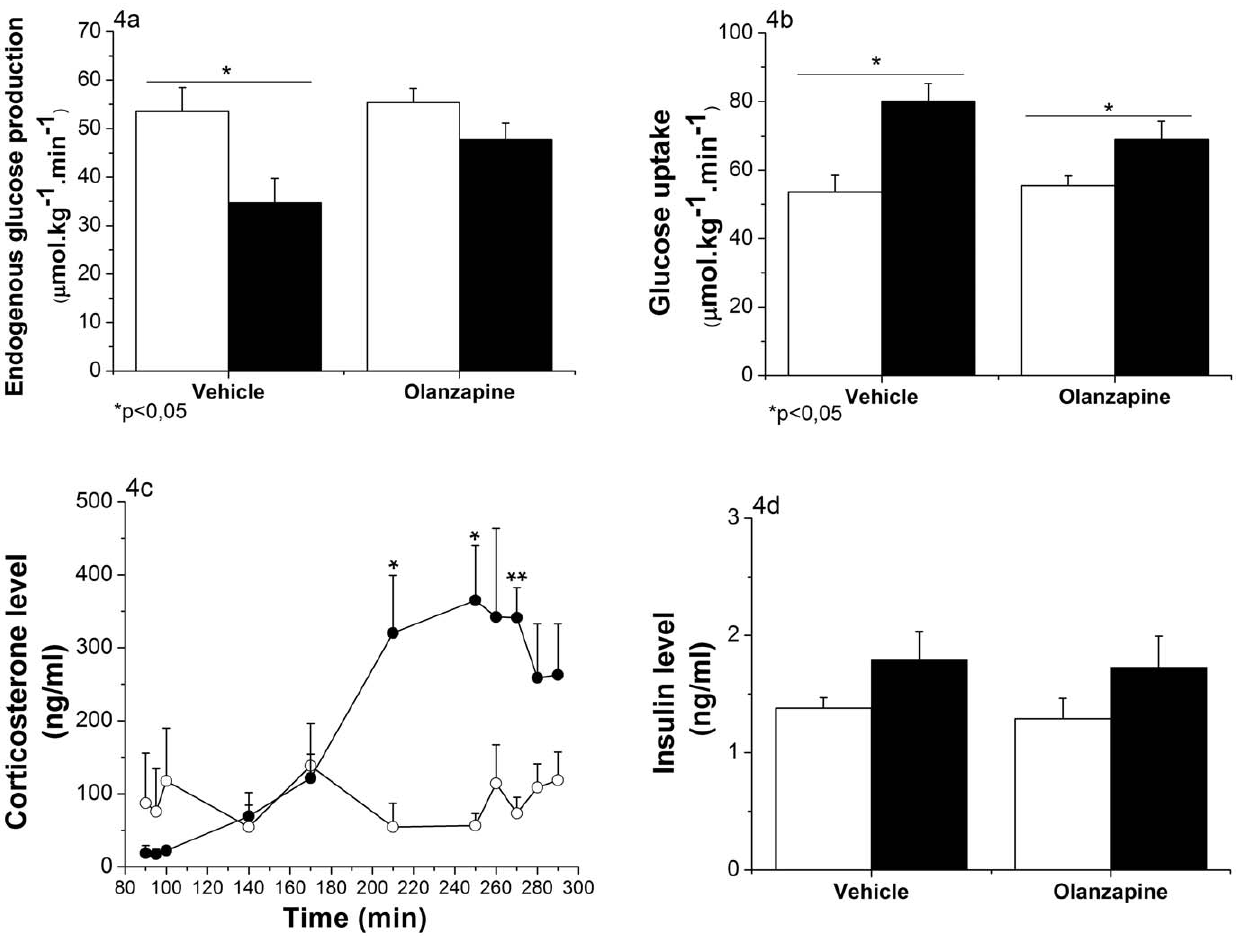
Figure 4. Effects of intragastric infusion of Olanzapine on liver insulin sensitivity (Experiment 2). (Vehicle group n=8, Olanzapine group n=7) 4a: Endogenous glucose production at basal (mean of 3 time points: t=90 to t=100; white bars) and during the hyperinsulinemic state (mean of 5 time points: t=250 to t=290; black bars). EGP significantly decreased during the hyperinsulinemic state for the vehicle group (p=0.018, One- Way ANOVA) and remained unchanged in the Olanzapine group (p=0.111, One-Way ANOVA). 4b: Glucose uptake at basal (mean of 3 time points: t=90 to t=100; white bars) and during the hyperinsulinemic state (mean of 5 time points: t=250 to t=290; black bars). Glucose uptake is significantly increased in both the vehicle (p=0.002, One-Way ANOVA) and Olanzapine group (p=0.046, One-Way ANOVA). 4c: Plasma corticosterone levels were significantly elevated by the IG infusion of Olanzapine (ANOVA repeated measures; Time, p , 0.001; Time * Group, p , 0.001; Group, p=0.039). Vehicle-treated animals = white dots; Olanzapine-treated animals = black dots. 4d: Plasma insulin levels were elevated 1.3-fold during the hyperinsulinemic state (mean of 3 time points; black bars) compared to the basal level (mean of 2 time points; white bars) (ANOVA repeated measures; Time, p=0.062; Time * Group, p=0.956; Group, p=0.706). *p , 0.05,**p ,